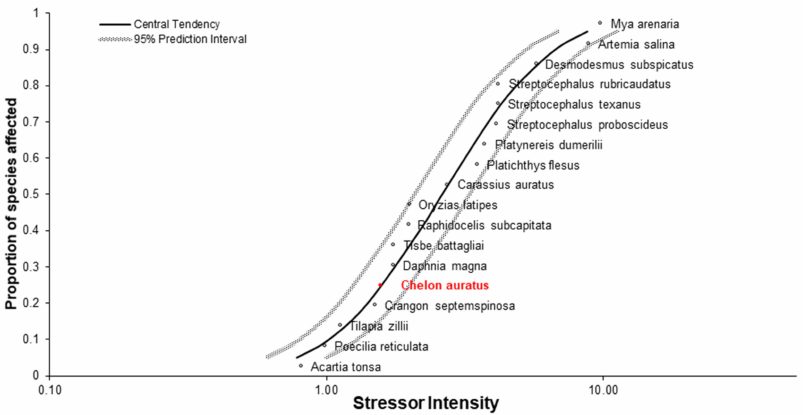
Figure 7. Species sensitivity distribution calculation: golden grey mullet included amongst a range of aquatic test organisms to demonstrate general sensitivity as related to a broad range of aquatic